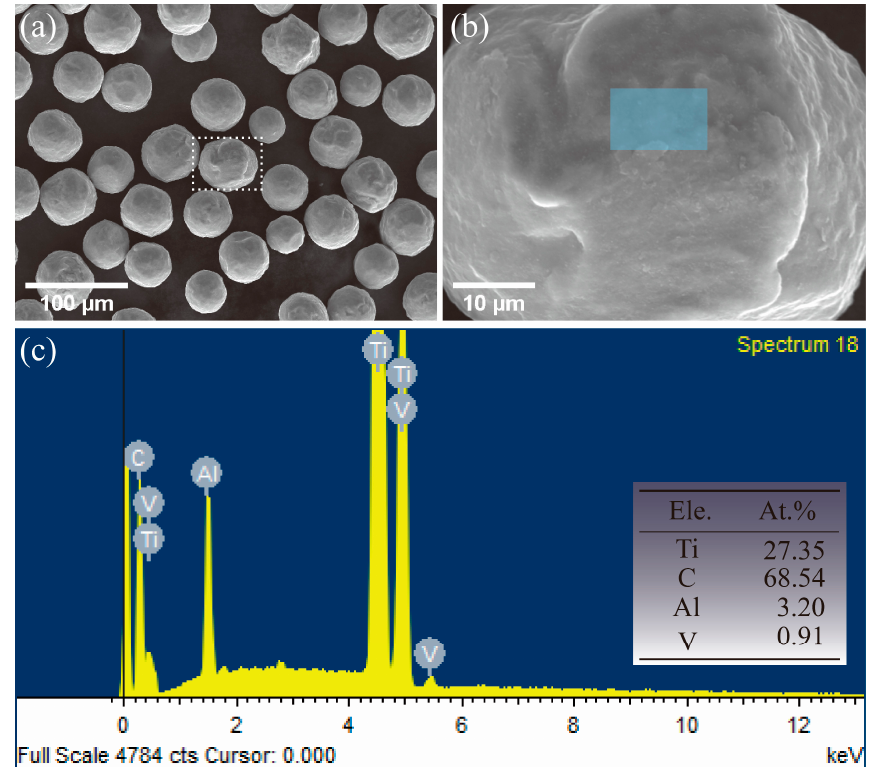
Figure 6. SEM images of #1 GNSs/Ti64 composite via powders planetary BM ( a ), the magnified box ( b ), and the EDS spectra ( c ).